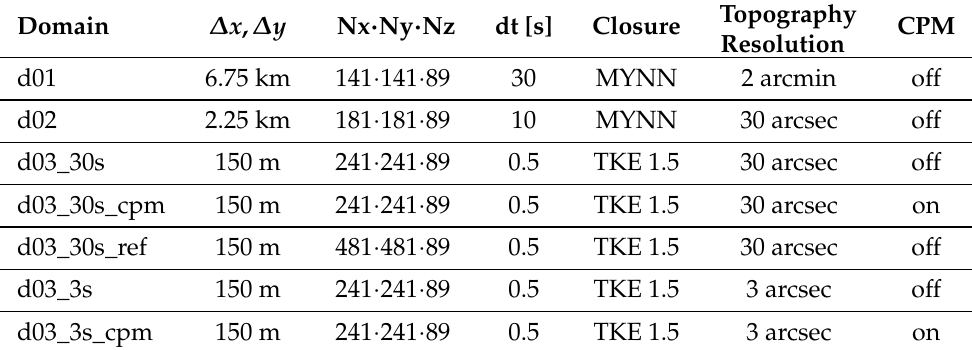
Table 1. Information on nested simulation domains include simulation name, horizontal grid spacing, number of grid points, time step, turbulence closure method, resolution of topography, and use of CPM. All domains use the same vertical grid spacing, stretching from 21 m near the bottom surface to 170 m at 2 km a.s.l., and up to 400 m aloft, selected to closely follow the levels used by the ECMWF forcing data below 5000